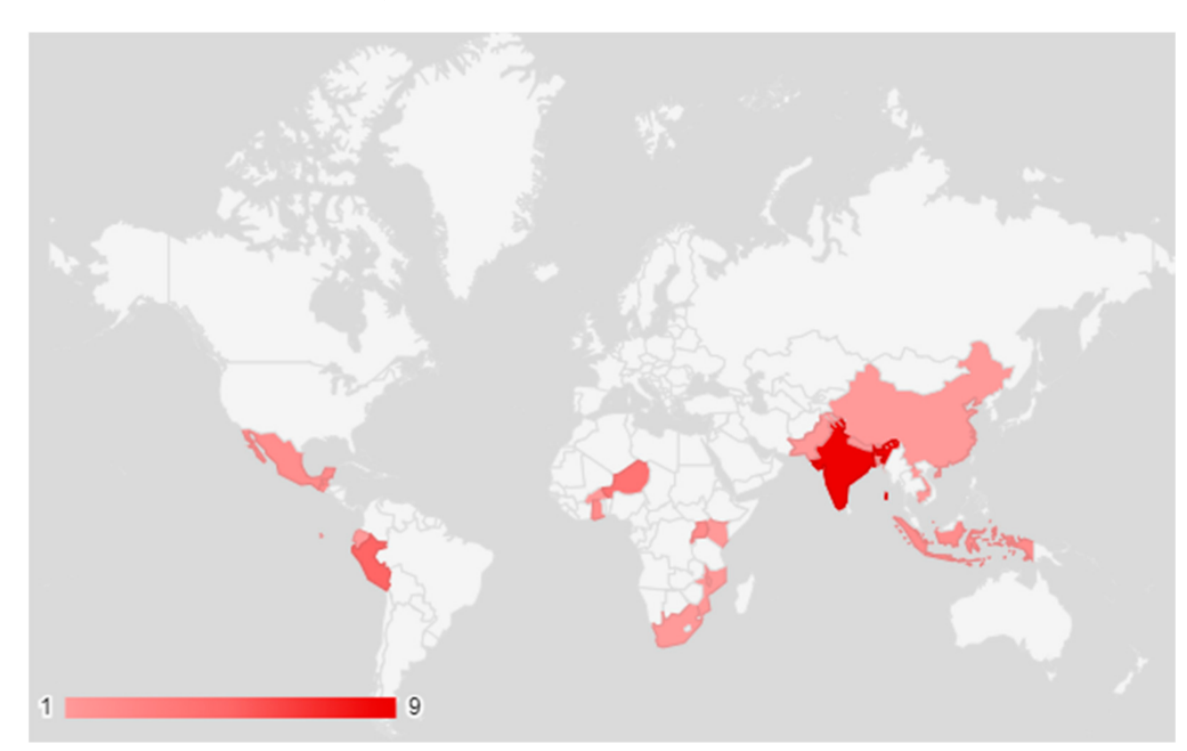
Figure 7. Geographic distribution of the evidence base.